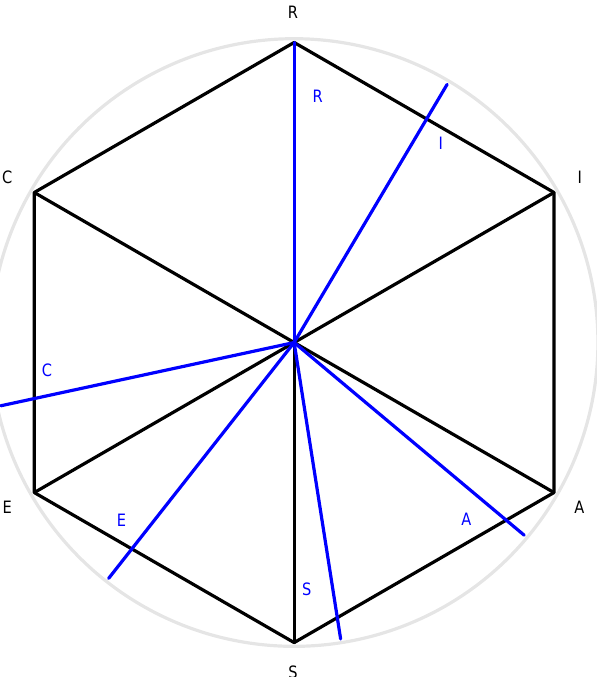
Figure 2. Projection of the RIASEC dimensions into the perfect hexagon based on a sample of a South German University ( N = 734)